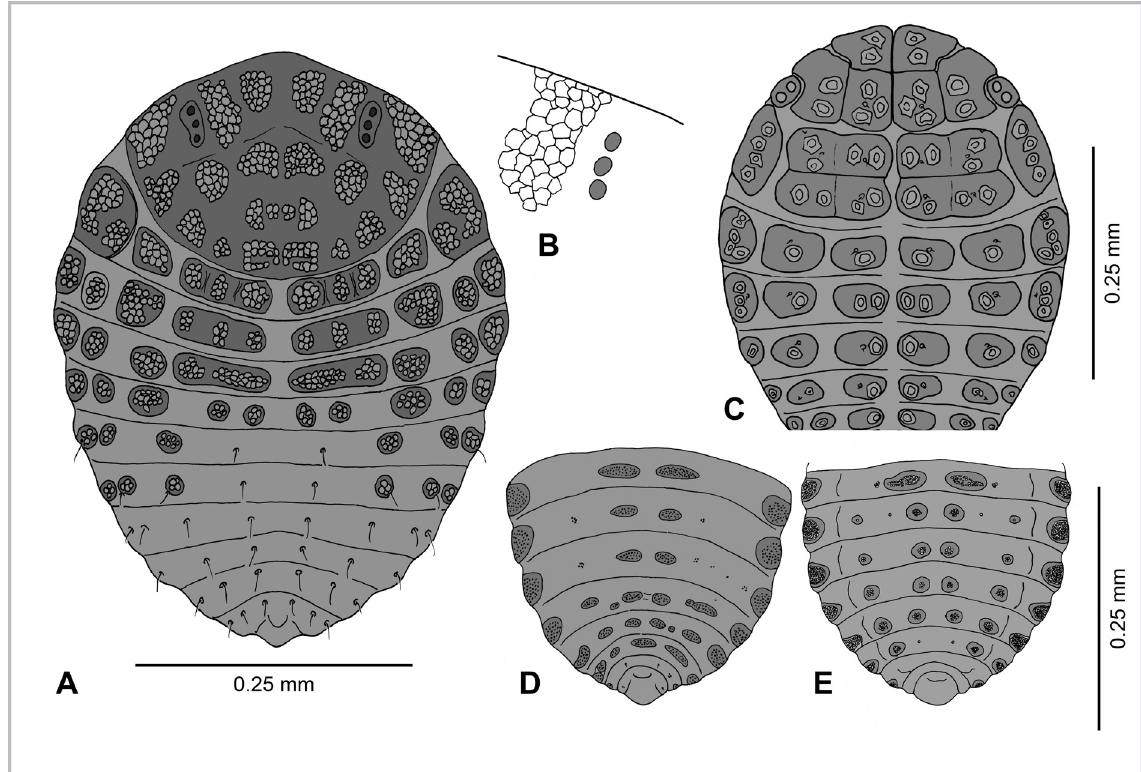
Fig. 80. Pineus (Pineus) cembrae (Cholodkovsky, 1888). A–B . Adult aptera; in B showing outer intraocular group of wax gland pits (after Inouye 1953, modified.). C . Hibernating nymph (after Inouye 1953, modified from Pashchenko 1988). D–E . Abdomen of gallicola (D) and sexupara (E) (after Börner, modified from Heie 2004).